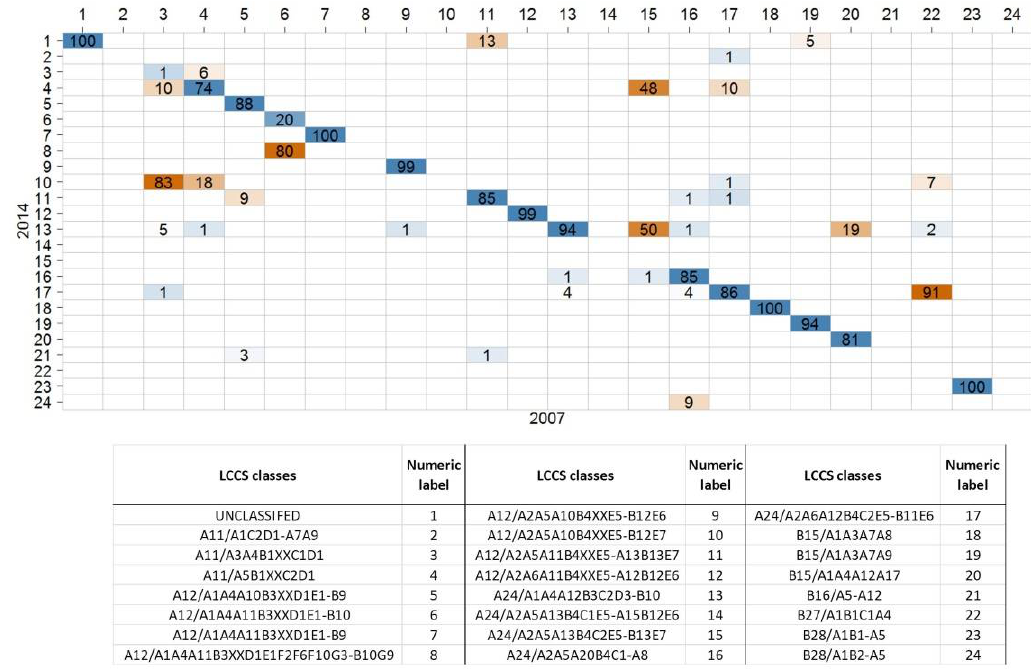
Figure 7. Land Cover Classification System (LCCS) habitat class transition matrix for 2007 to 2014 for the SC site.